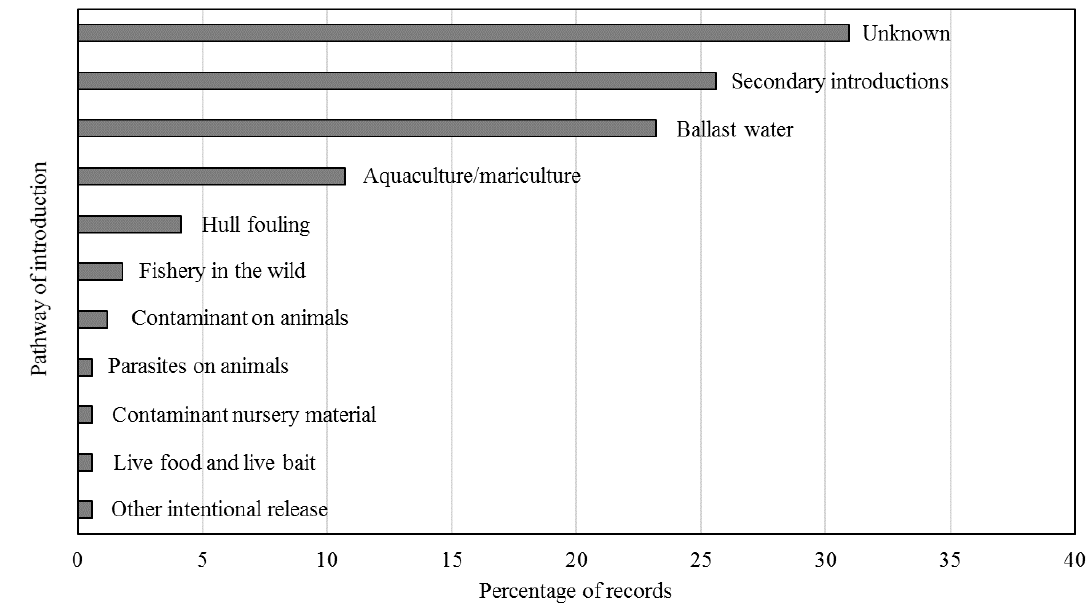
Figure 6. The percentage distribution of the different NIS introduction pathways. The categories of pathways of introduction are based on the CBD pathways categorization scheme [33].